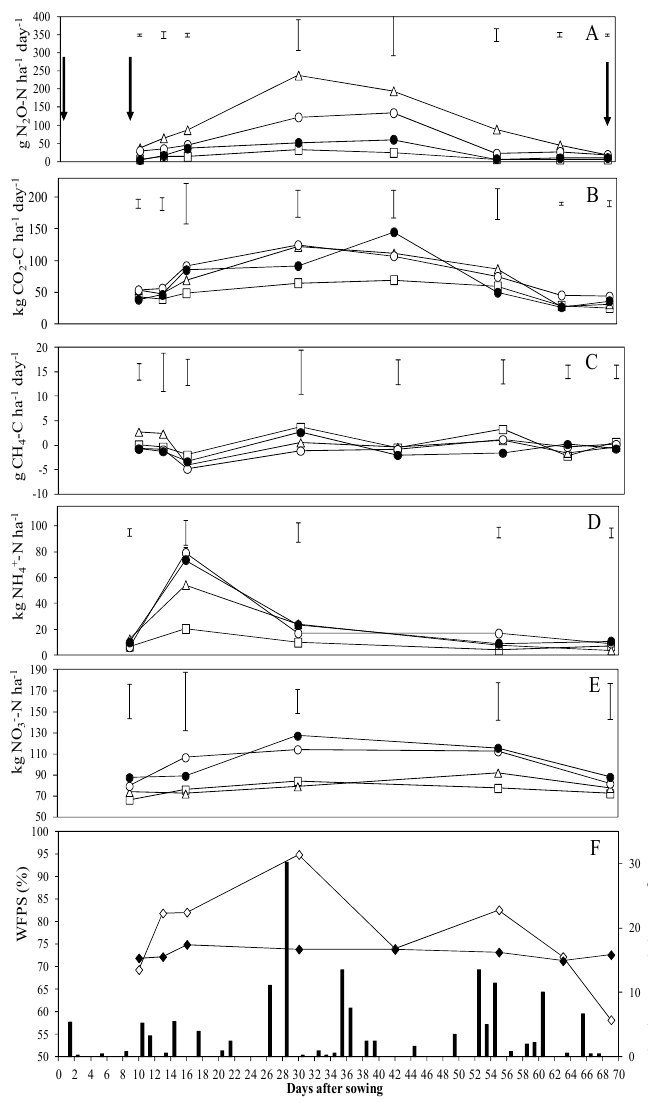
Figure 1. Daily greenhouse gas (GHGs) emissions ( A–C ), soil NH 4+ -N ( D ) and NO 3 − -N ( E ) contents, soil water-filled pore space (WFPS) ( ◊ ), soil temperature ( ♦ ) and rainfall (black bars) ( F ). Unfertilized ( □ ), urea ( △ ), ammonium sulfate nitrate (ASN) ( ○ ) and ASN plus the NI 3,4-dimethylpyrazole phosphate (ASN+DMPP) ( ● ). Arrows show in order from left to right: sowing, fertilizer application and harvest. Vertical lines indicate least significant difference (LSD) ( p < 0.05; n = 4) for each sampling day. Table 1. Physical and chemical properties of soil (0 – 30 cm depth).